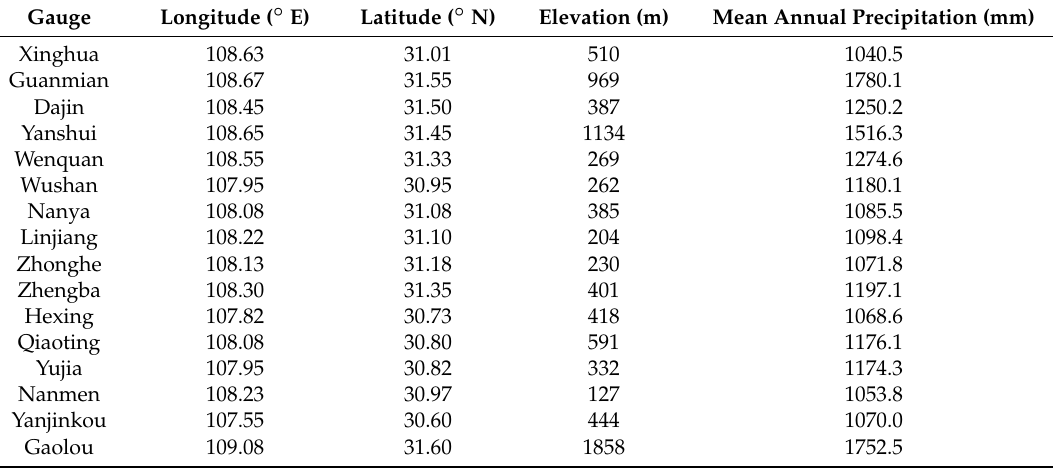
Table 1. Rain gauges, location, and statistics of mean annual precipitation from 2009 to